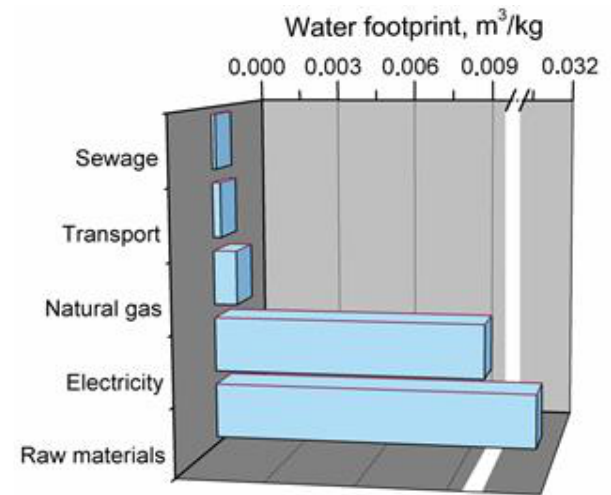
Figure 11. Main components of production system generating water footprint of glass fibers.